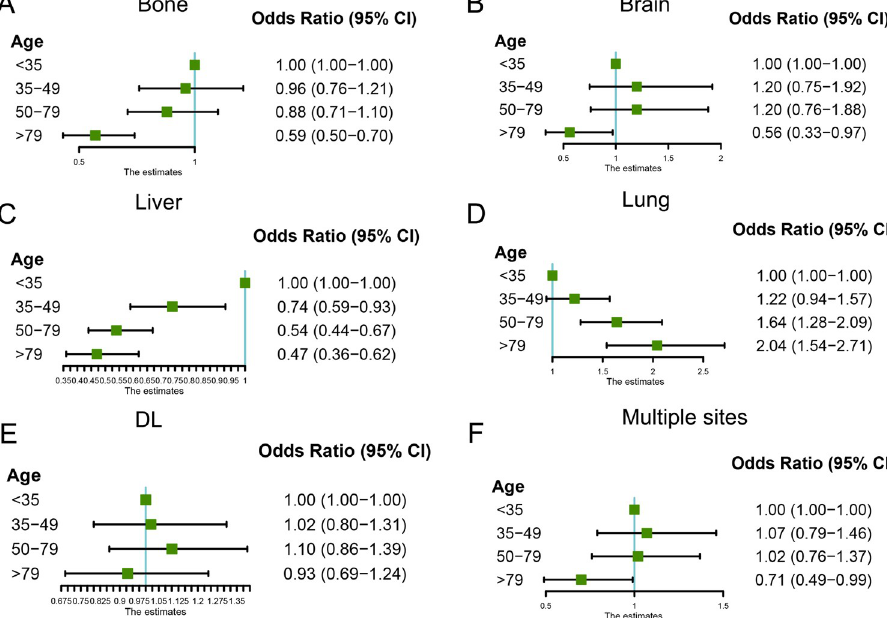
Fig 3. Multivariable logistic regression analyses predicting different metastasis sites in MBC patients. ( A ) Bone metastasis; ( B ) Brain metastasis; ( C ) Liver metastasis; ( D ) Lung metastasis; ( E ) DL metastasis; ( F ) Multiple sites metastasis. DL, Distant Lymph